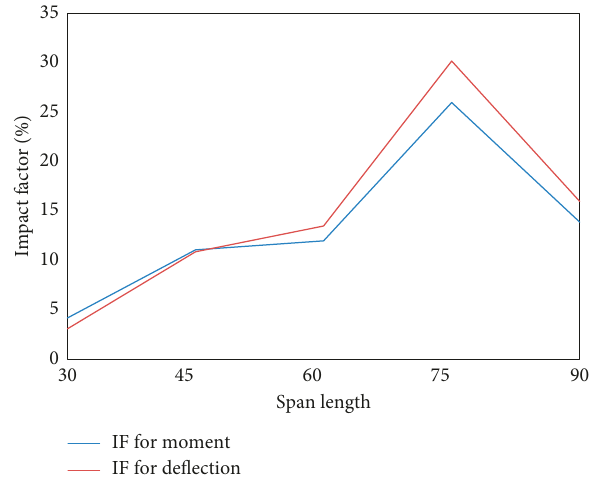
Figure 6: Effect of span length on the dynamic impact factors for Bridge